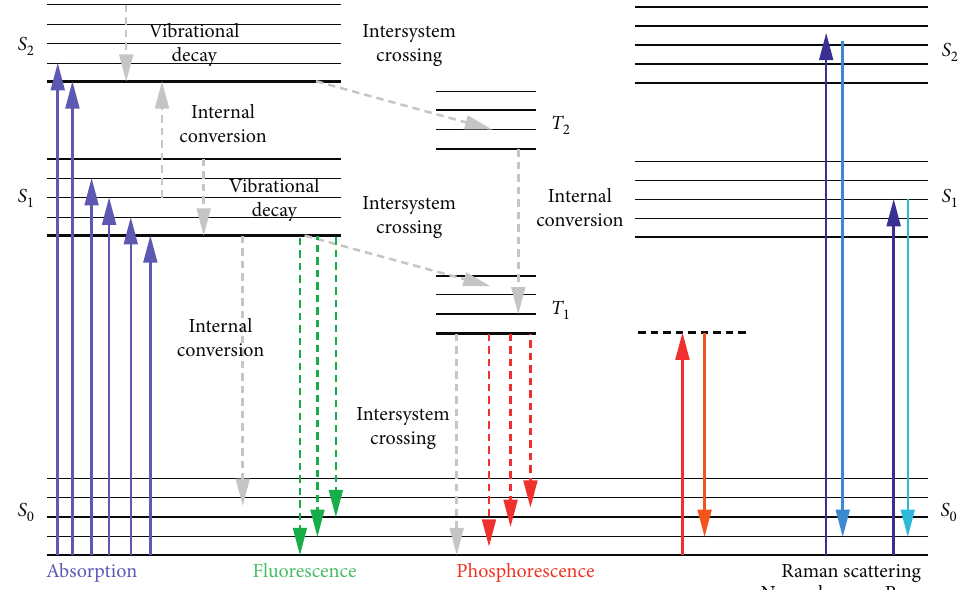
Figure 2: Jablonski diagram showing different types of electronic transitions (absorption, emission, and scattering) that can take place accompanied with different processes [58].